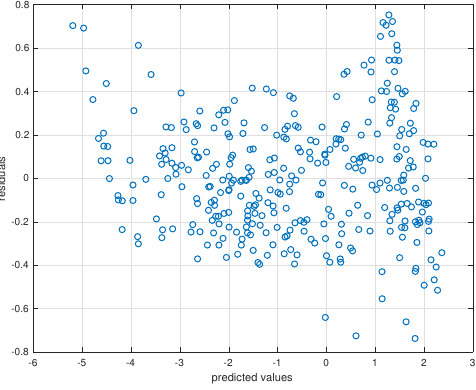
Figure 7. Residuals versus model